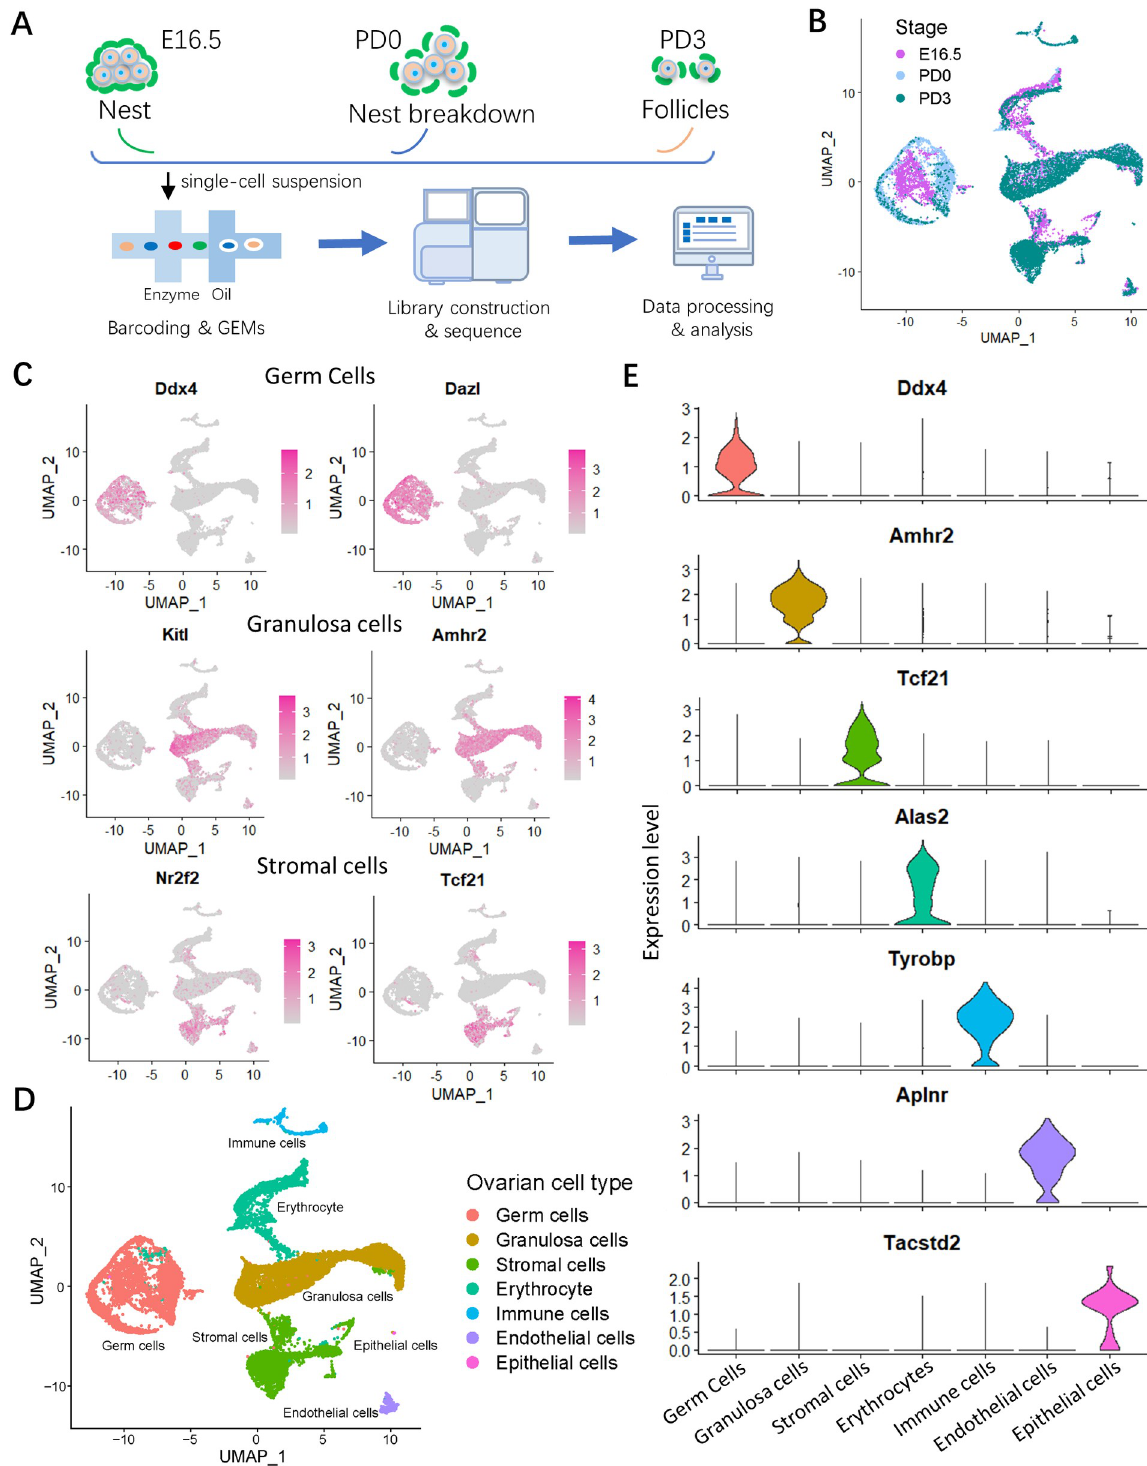
Fig 1. scRNA-seq identified ovarian cell types during PF formation. ( A ) Schematic diagram of the scRNA-seq analysis procedure. Ovaries were isolated and disaggregated into single cell suspensions; cells were barcoded and used for library construction onto 10 × Genomics platform and the data produced after sequencing analyzed by dedicated software. ( B ) UMAP plot of ovarian cells colored by the selected developmental time points (that is Stage). E16.5 for medium orchid, PD0 for light blue and PD3 for dark cyan. ( C ) Feature plots of specific marker genes of